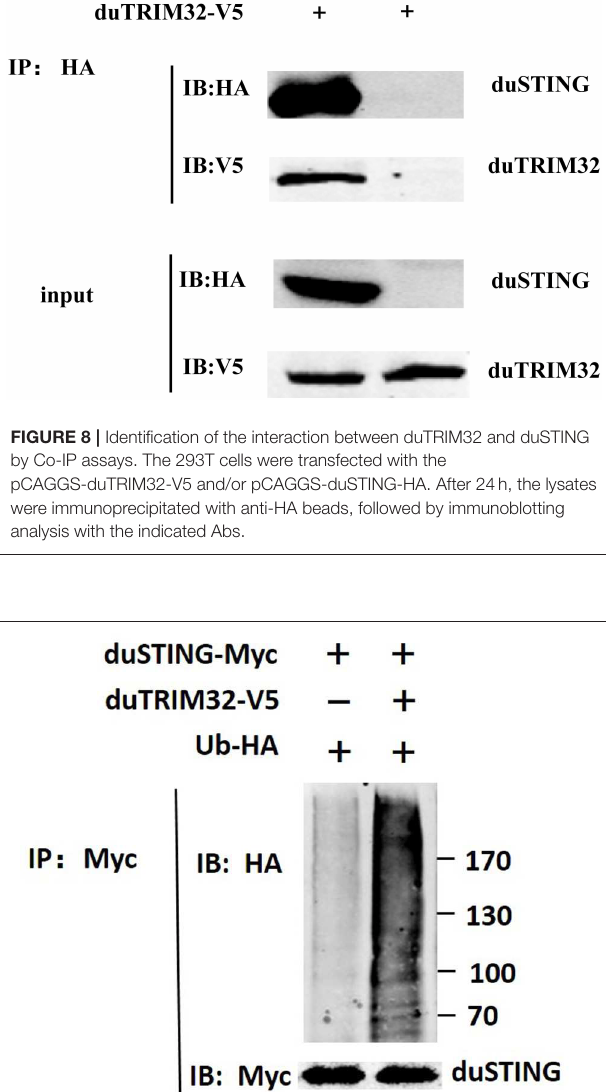
to inhibit the replication of H9N2 AIV (22). In this study,